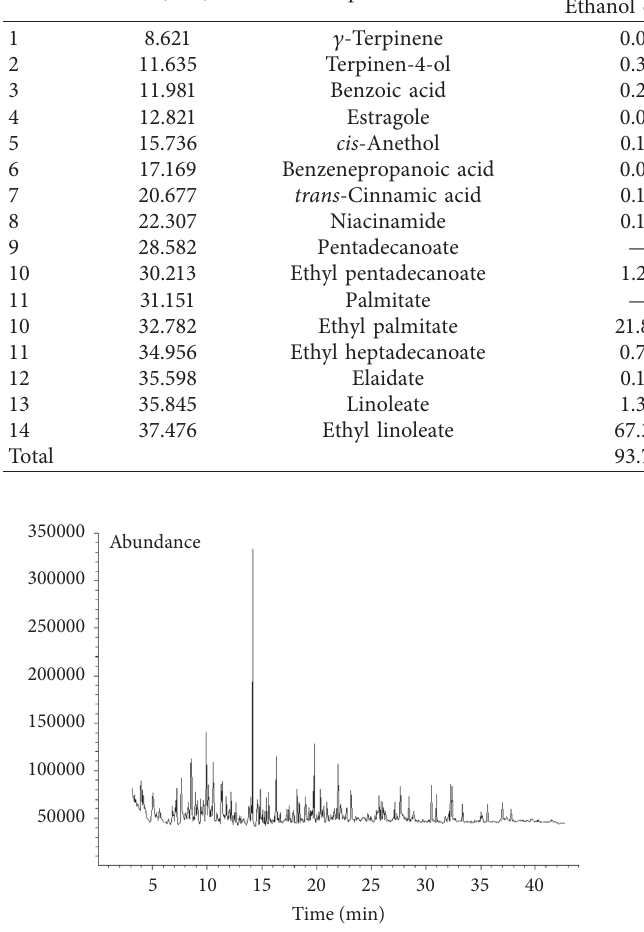
Figure 1: Total ion flow chromatogram of volatile components in P . geesteranus powder.